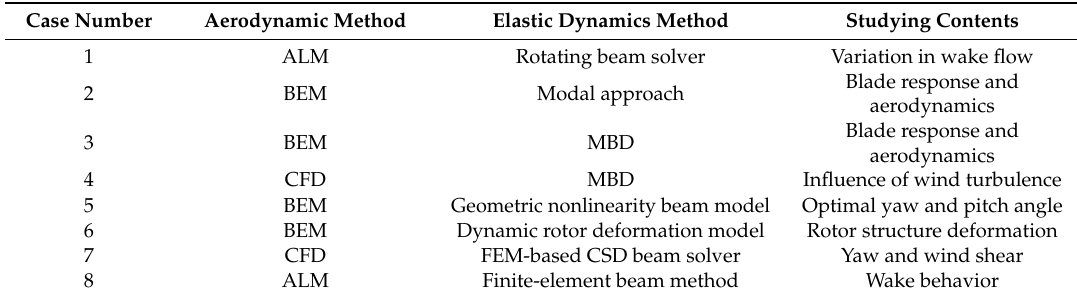
Table 5. Detailed information about the solved method on the aerodynamic performance and the structural responses in di ff erent cases.